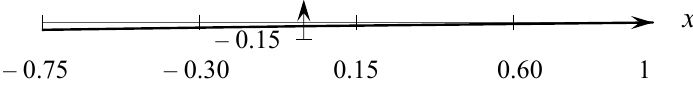
Figure 4. Graphical representation of the function ˙ Q 0